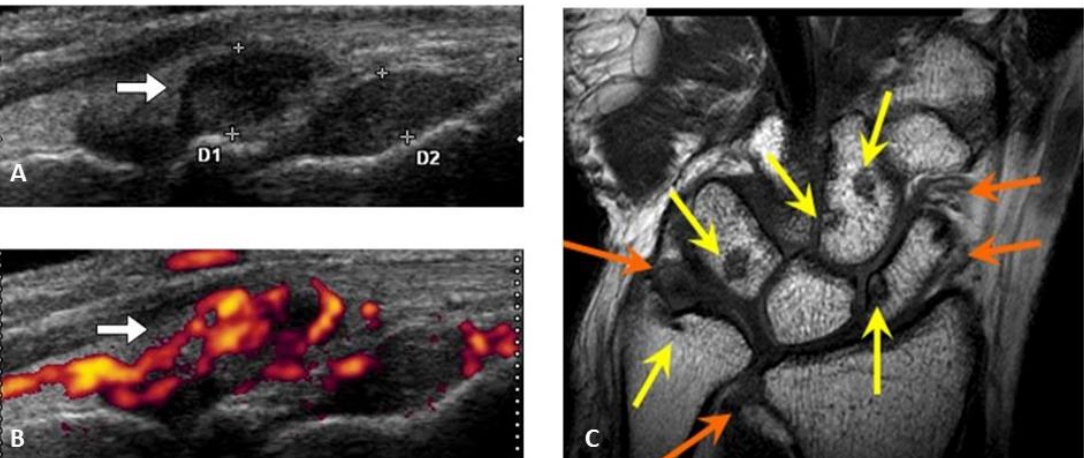
Figure 2. Rheumatoid synovium by ultrasonography and bone erosion by MR-imaging. Synovial hypertrophy (white bar) by systematic multiplanar grayscale ultrasonography ( A ), marked signals of synovial flow by power doppler ultrasonography ( B ), bone erosion (( C ), yellow bar) and synovial hypertrophy (( C ), orange bar) by MR-imaging are characteristic images in rheumatoid arthritis.